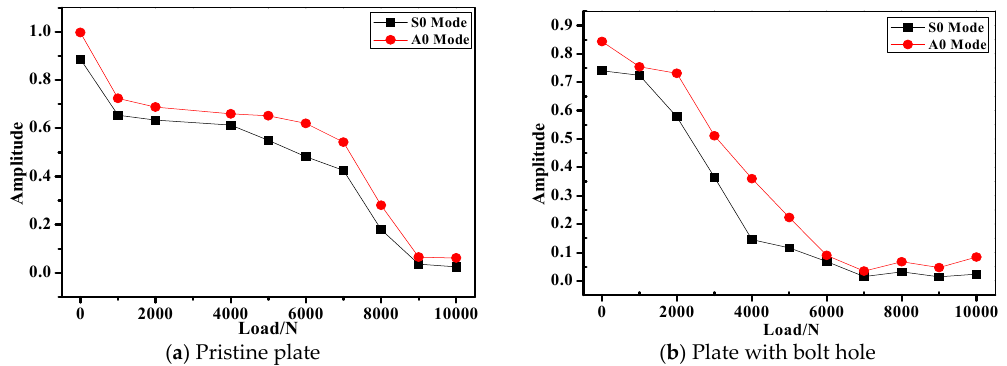
Figure 12. Amplitude of S0 and A0 mode of a pristine and drilled composite plate during the axial tension test.